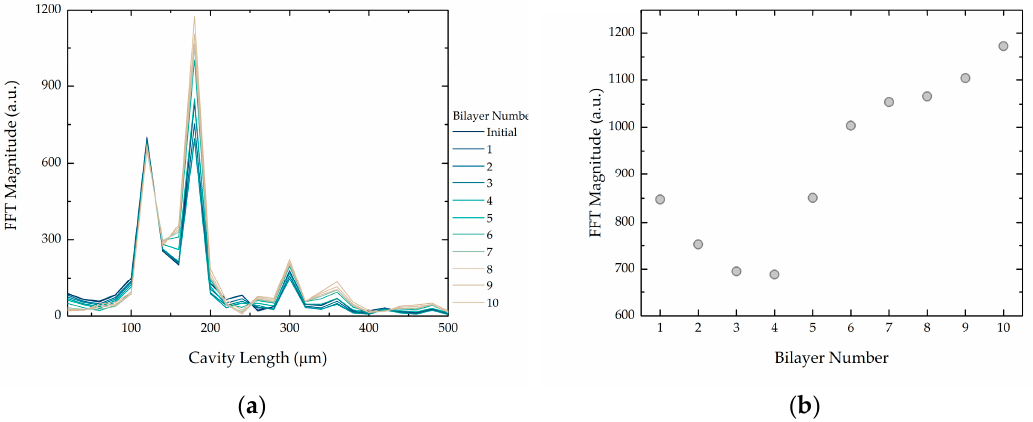
Figure 5. ( a ) FFT signals for each bilayer number; ( b ) Peak 2 magnitude value, for each bilayer